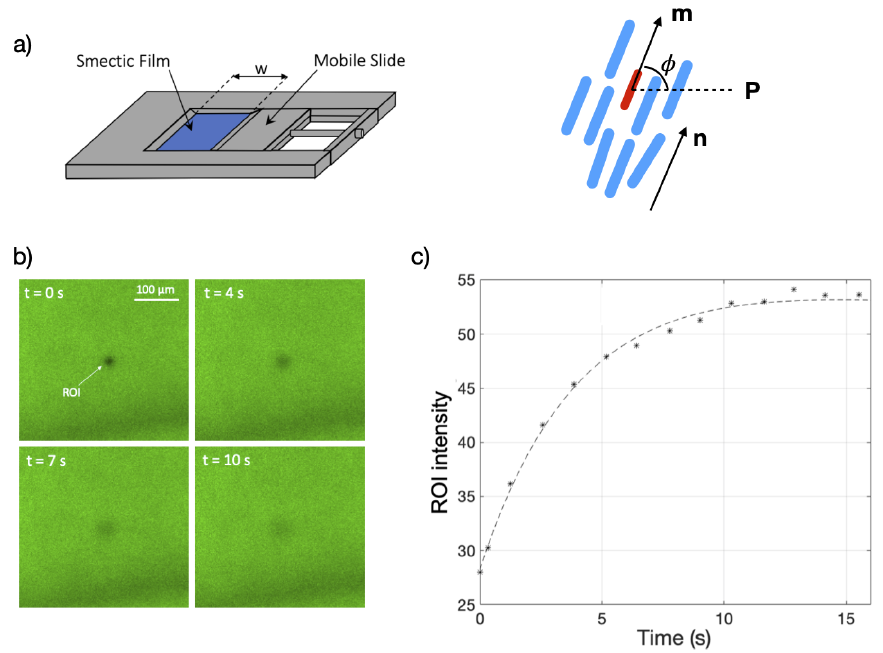
Figure 1. ( a ) Left: Scheme of the film holder mounted on the microscopy table. Right: Schematic of the dye orientation drawn in red in the nematic matrix drawn in blue. n is the nematic director, m is the transition moment, and P is the polarization plane of the excitation beam. ( b ) Snapshots from the experiment showing the fluorescence intensity recovery of a bleached region (exposed for 8 s to full laser power before t = 0). The film does not contain defects in the vicinity of the region of interest (ROI). ( c ) Time dependence of the measured mean intensity of the bleached ROI presented in Figure 1b. The recovery time is about 10 s. The dashed line is an exponential fit.